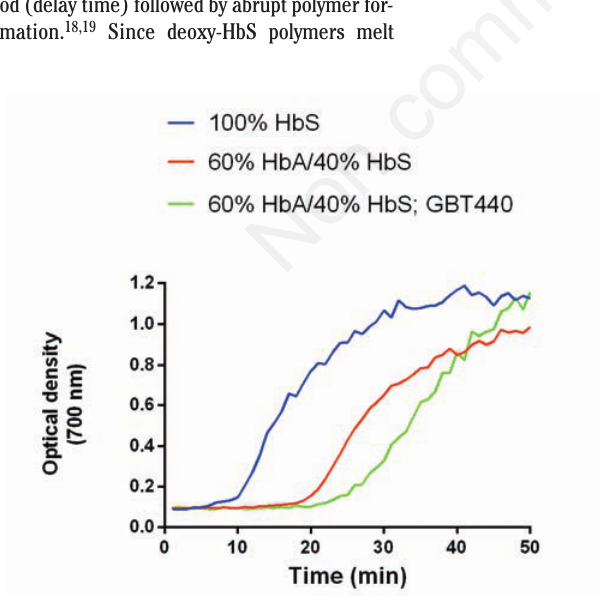
Figure 3. GBT440 inhibits in vitro sickling of sickle cell trait (SCT) blood under extreme hypoxia. A) Oxygen equilibrium curves (OECs) of SCT blood treated in vitro with varying con- centrations of GBT440. B) Percentage of sickled SCT red blood cells at the indicated oxygen tensions corresponding to the OECs in A. SCT blood (n=1 sample) at 36% Hct (~1.8 mM of hemo- globin) was